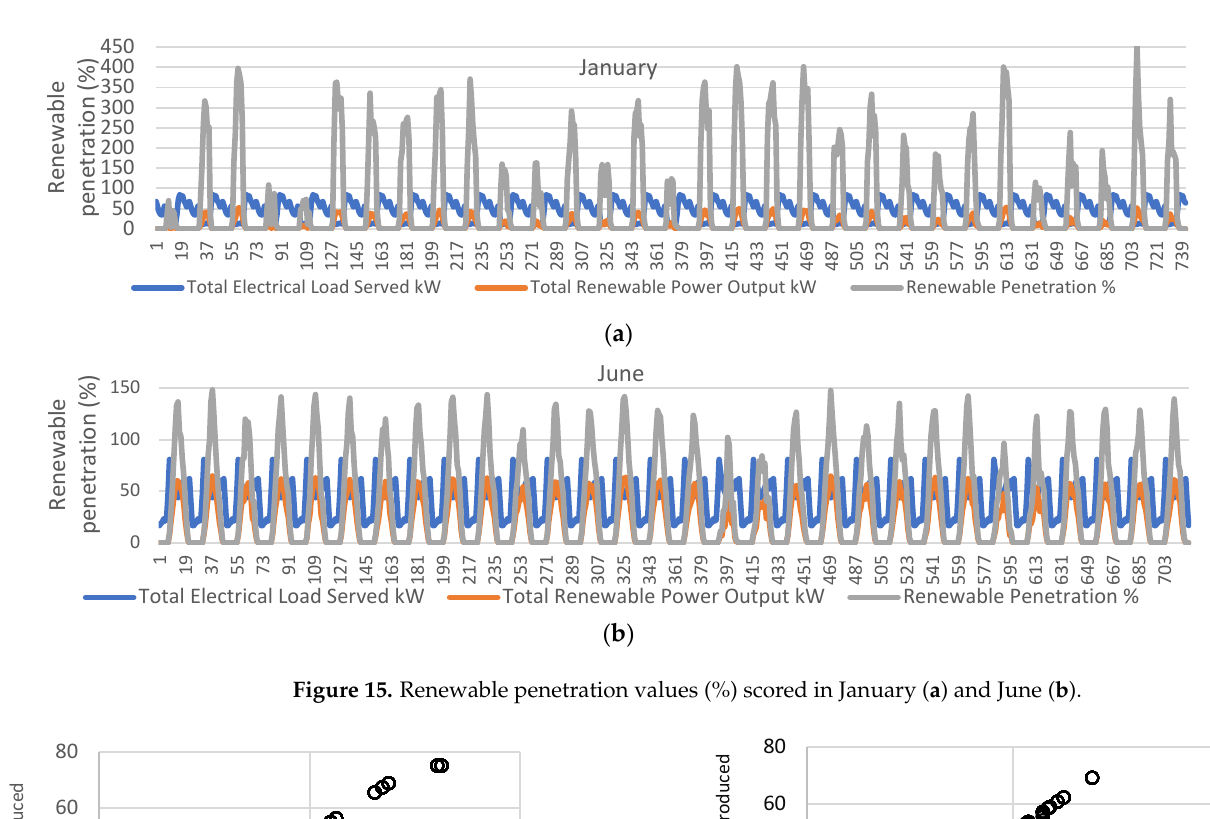
Figure 16. Class index; the potential renewable energy (kW) that served the total energy demand (kW), January ( a ), June ( b ).